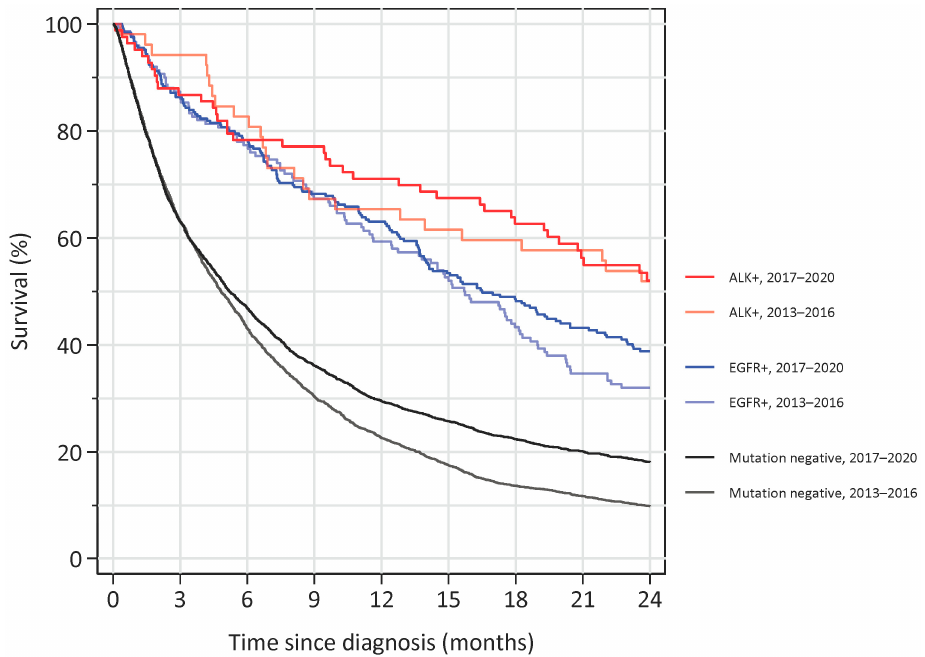
Figure 7. Overall survival for non-squamous NSCLC diagnosed at stage IV from either 2013–2016 or from 2017–2020 and followed until June 2022. Patients diagnosed with ALK mutations are shown in red colours, EGFR mutations are shown in blue colours, and patients without ALK- or EGFR- mutations are shown in a black/grey colour.